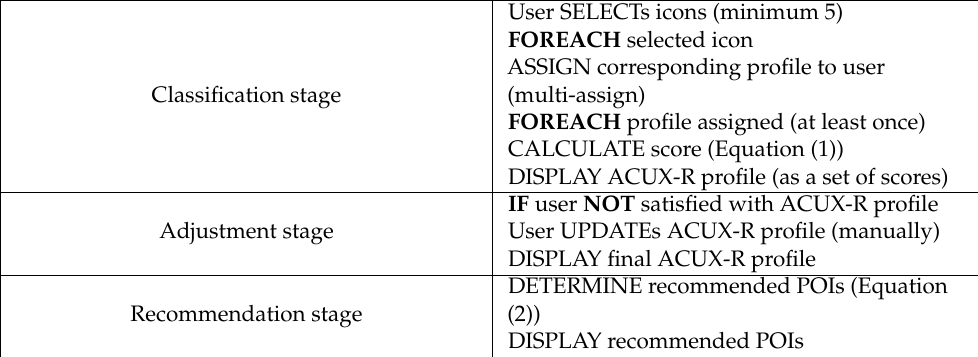
Table 1. The ACUX-R recommendation algorithm.